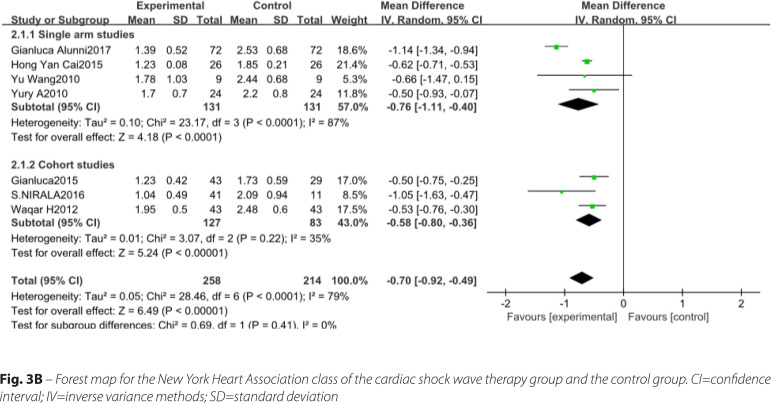
Forest map for the New York Heart Association class of the cardiac shock wave therapy group and the control group. CI=confidence interval; IV=inverse variance methods; SD=standard deviation